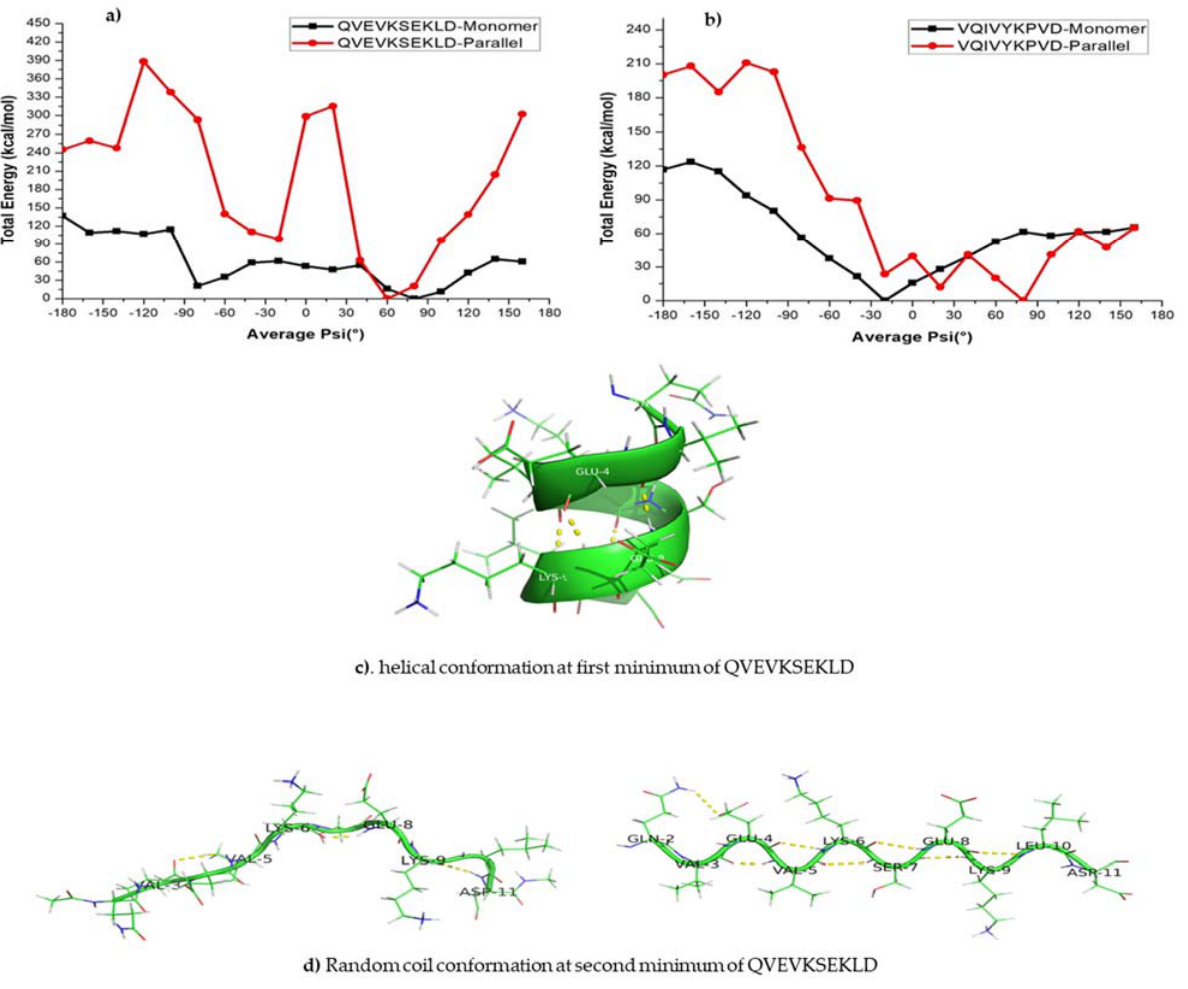
Figure 6. ( a , b ) Calculated total energy of conformations at different ψ angles using the PM7 level of theory. ( c , d ) The secondary structure that corresponds to the first minima and second minima respectively.